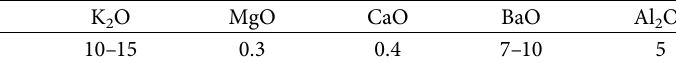
Table 2: Chemical composition of borosilicate glass